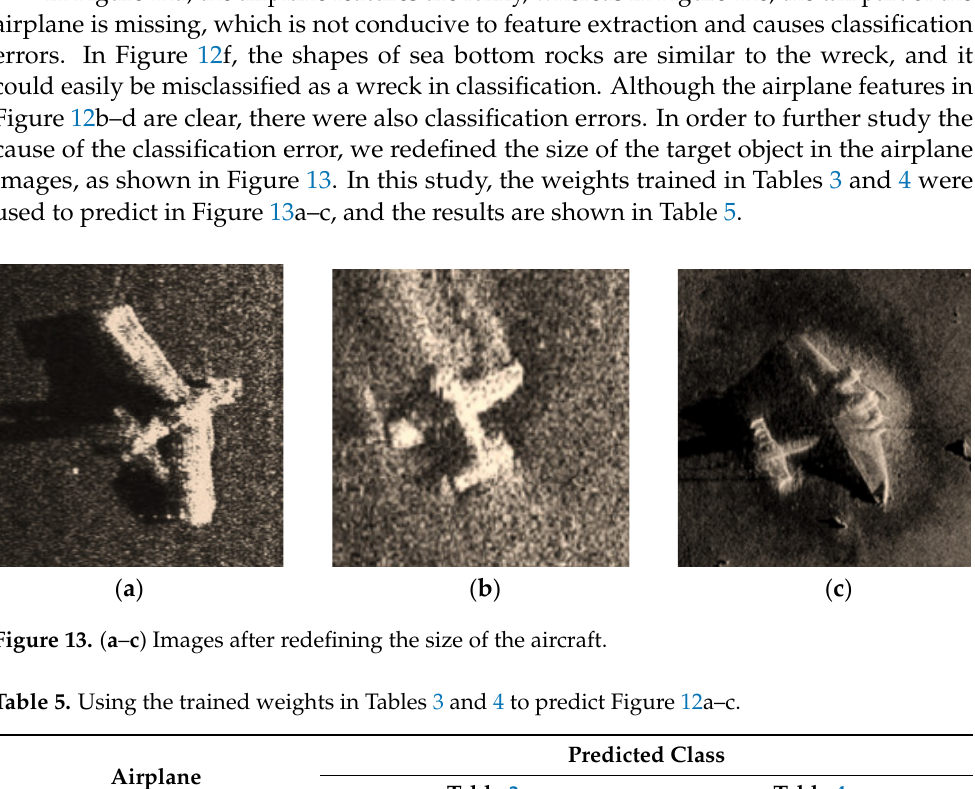
Figure 12. ( a ) Aircraft with fuzzy features. ( b – d ) Aircraft with smaller target object. ( e ) Aircraft with missing tail. ( f ) Pure seabed image.